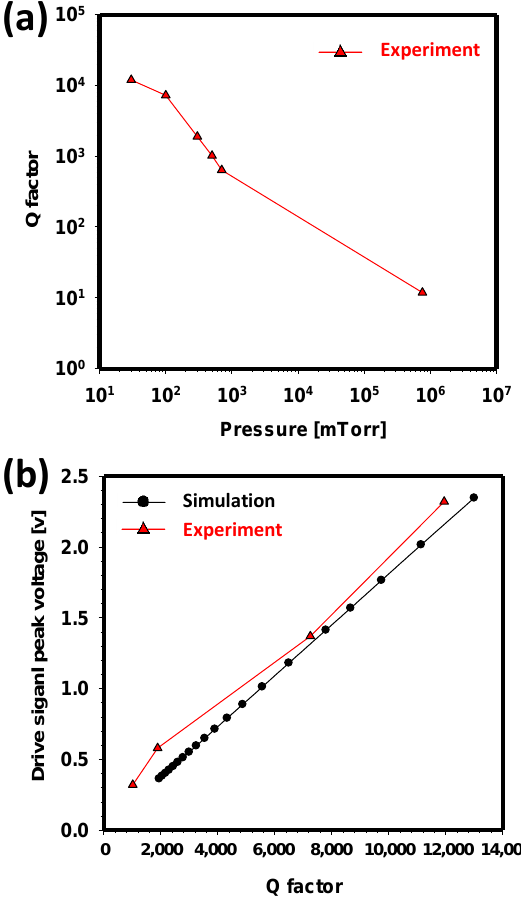
Figure 7. ( a ) Experimental result of the quality factor as a function of air pressure. ( b ) Comparison of the simulation and experimental results of the driving signal peak voltage versus air pressure.